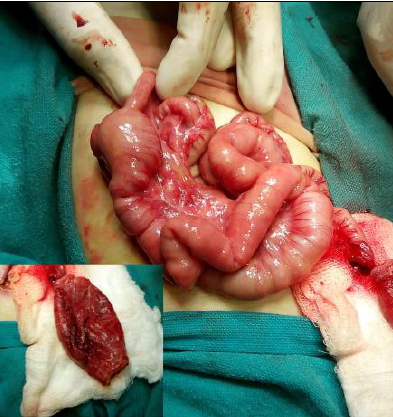
Figure 3: Segmental dilatation of ileum. Inset shows resected CPC.